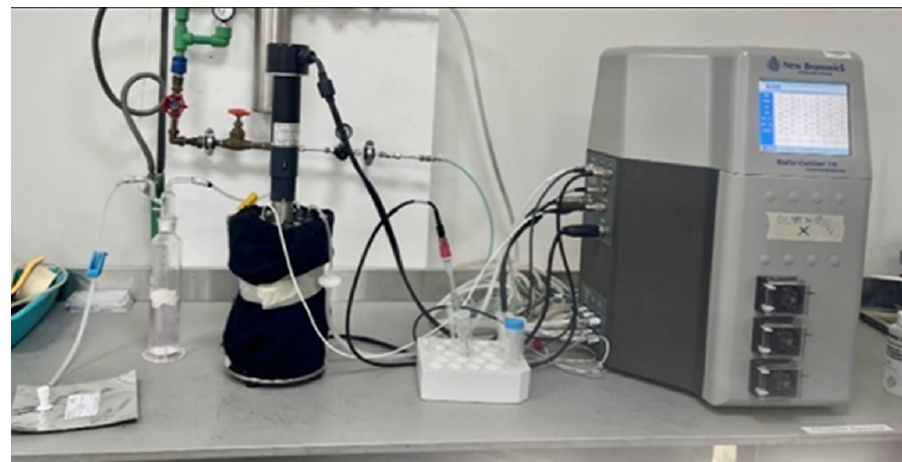
Figure 4. Experimental set-up of the study.